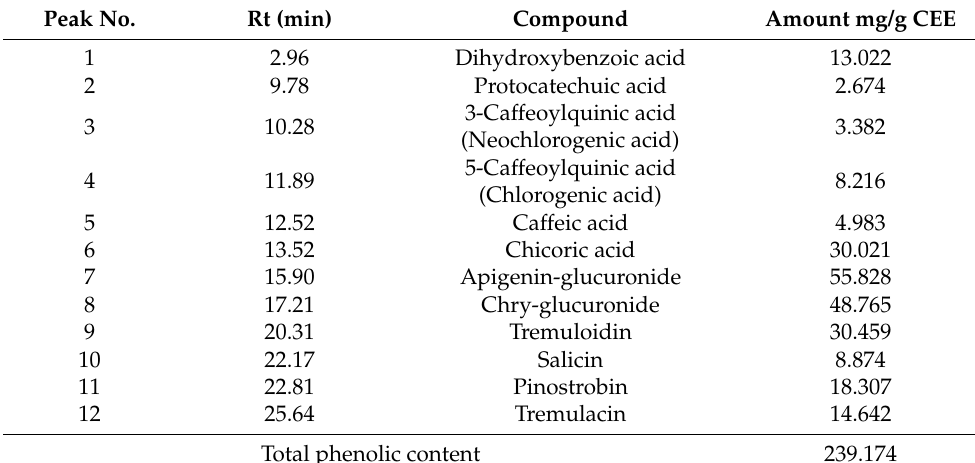
Table 4. The number of phenolic compounds in the poplar bud sample, expressed in mg/g chloro- genic acid equivalent (CCE).